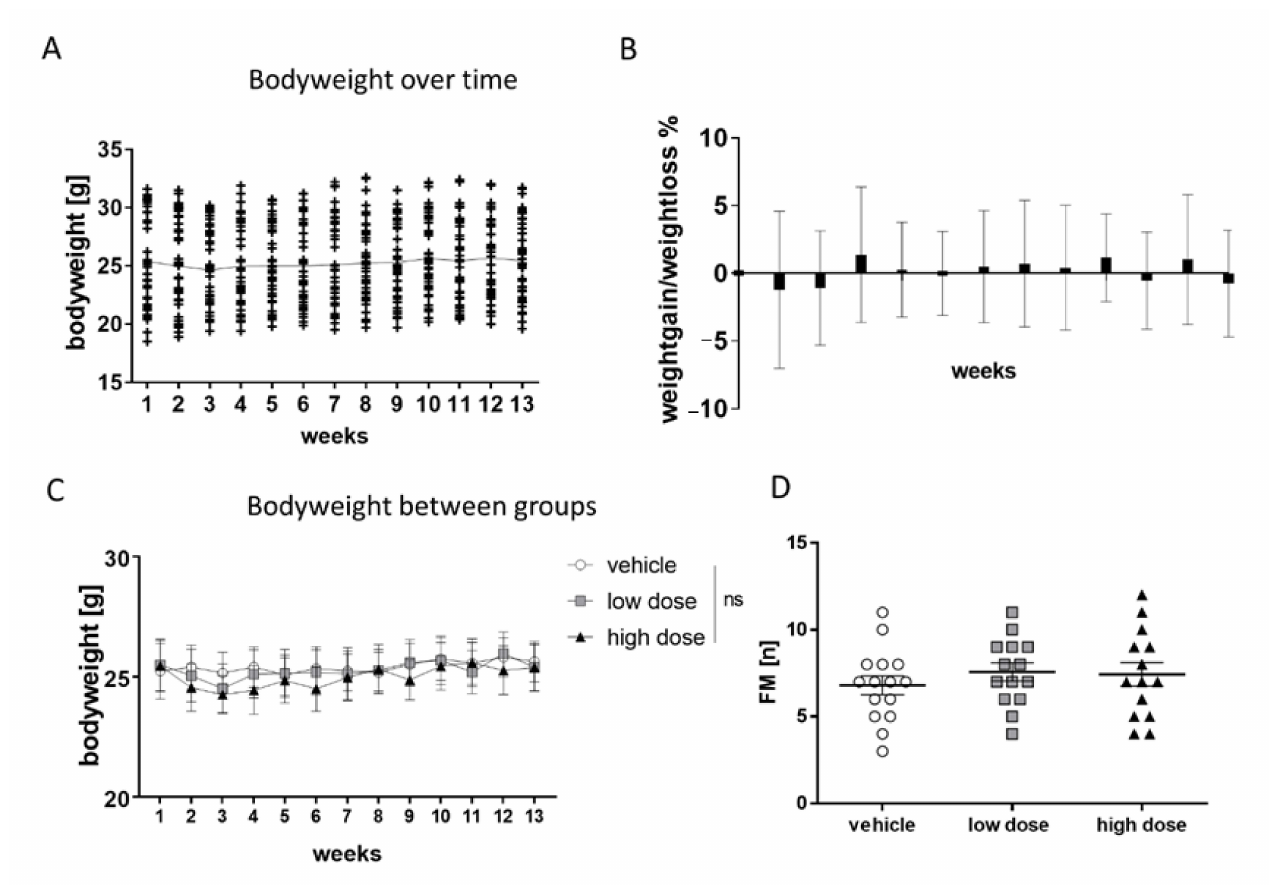
Figure 5. Safety profile of MTK film in mice. Body weight of the mice was assessed on a weekly basis for 13 weeks as a parameter of health. ( A ) Mean body weight did not significantly differ between the weeks. ( B ) Individual body weights did fluctuate less than +/ − 10% each week. ( C ) Body weights did not significantly differ between groups (high dose = 10 mg/kg/d; low dose = 3.3 mg/kg/d). ( D ) Fecal motility did not differ significantly between all groups. Data are shown as mean +/ − SEM. One-way ANOVA with Bonferroni post-hoc test or Student’s t-test was performed. p -values < 0.05 were considered